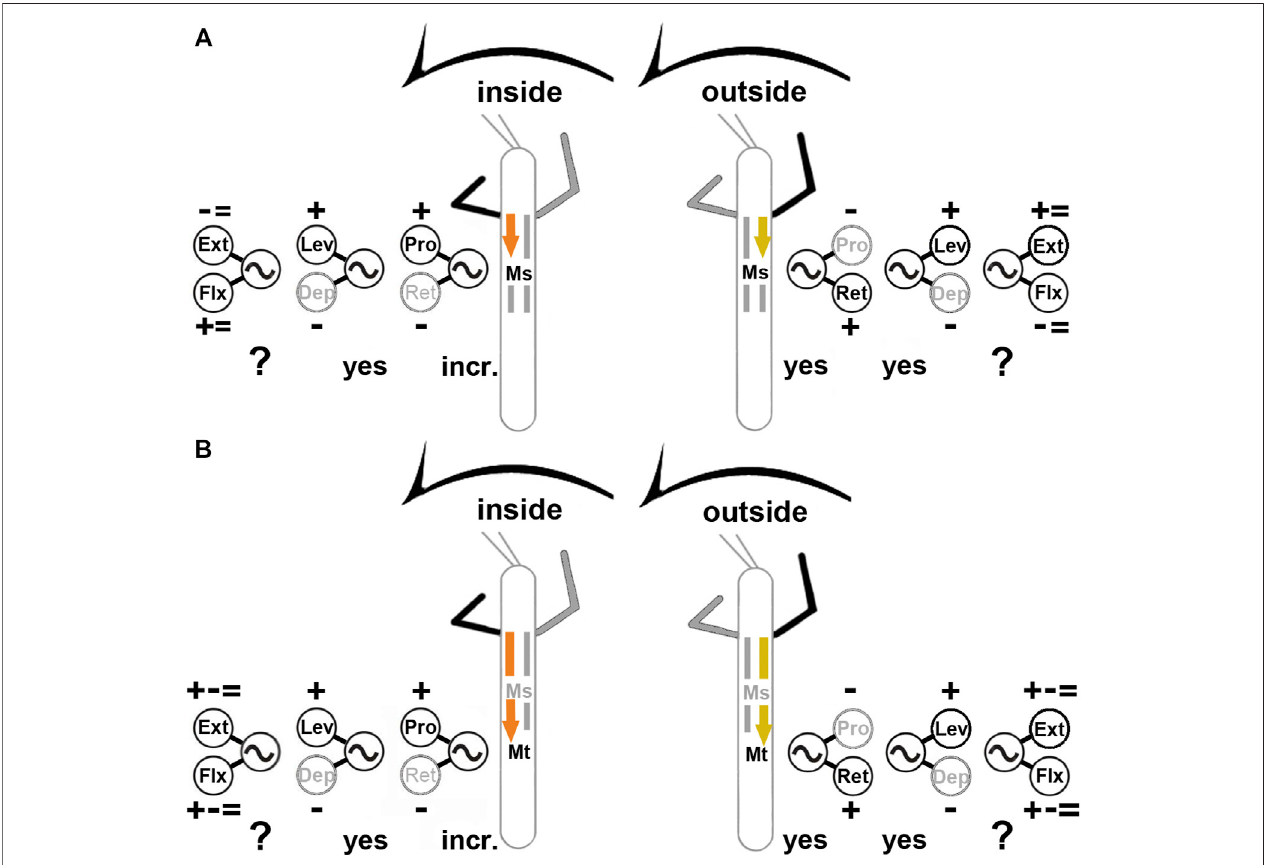
FIGURE 11 | Summary of observed in fl uences on the meso- (A) and metathoracic (B) MN pools during inside (left) and outside (right) turning of the front legs. “ + ” : increaseinMNactivity, “ − ” :decreaseinMNactivity, “ = ” :nochangeinMNactivityfound; “ incr. ” :increaseinCPGfrequency; “ yes ” : CPGaffected; “ ? ” :effectonCPGnot tested. Ext: extensor tibiae; Flx: fl exor tibiae; Lev: levator trochanteris; Dep: depressor trochanteris; Pro: protractor coxae; Ret: retractor coxae. Ms, Mt: meso- and metathoracic segment, respectively. The sketch indicates a stick insect with front legs in a fl exed (inside) or stretched (outside) position, and the arrow above indicating the turning direction, the arrow on the side the recorded thoracic segment. Note that “ + − = ” above the extensor and below the fl exor MN pools denotes that there were examples of increased, decreased and unchanged MN activity.